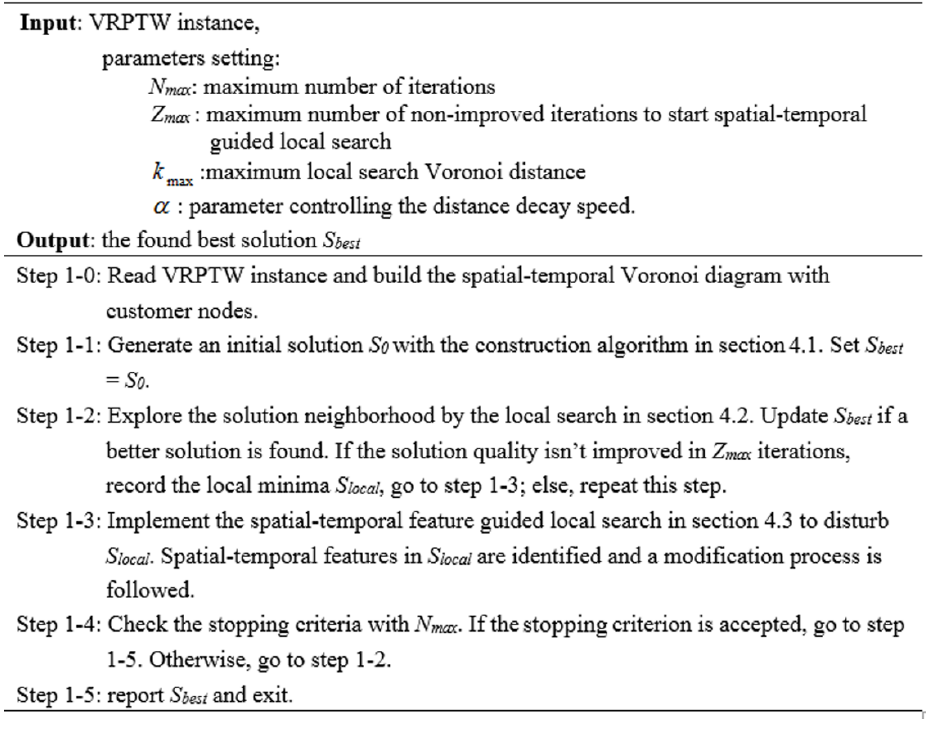
Figure 3. The framework of the spatial-temporal Voronoi diagram-based heuristic